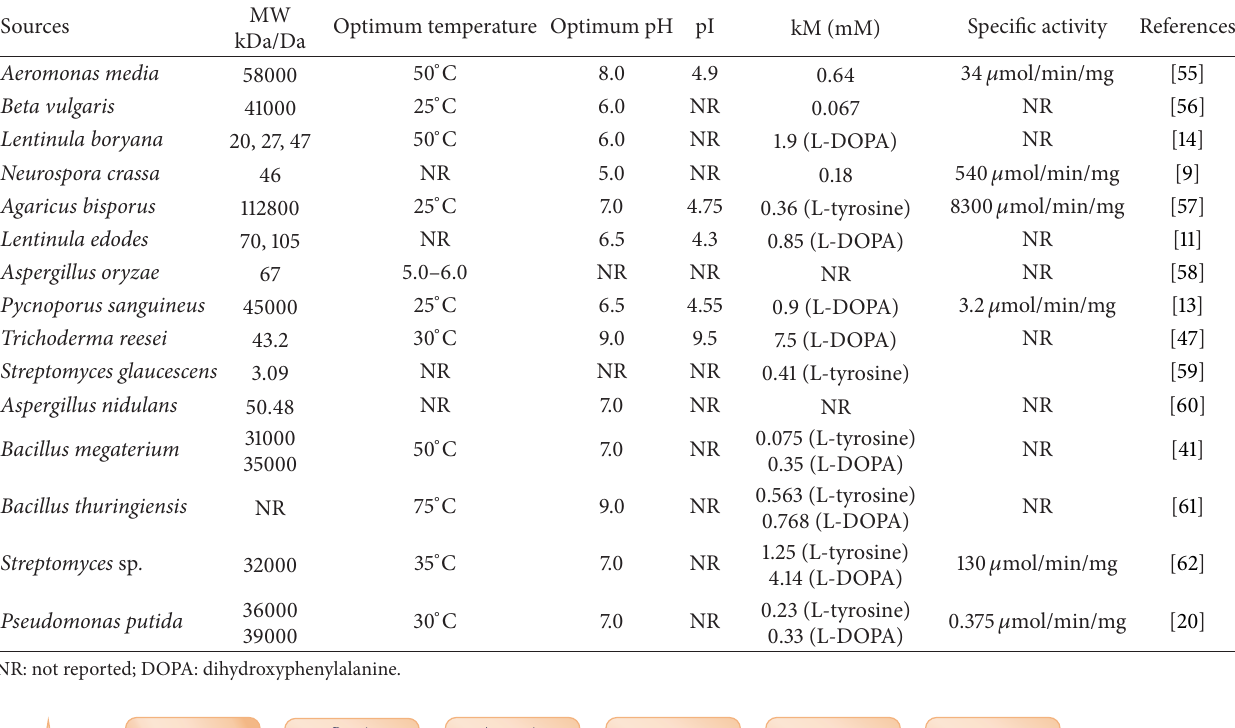
Table 1: Biochemical properties of tyrosinase.